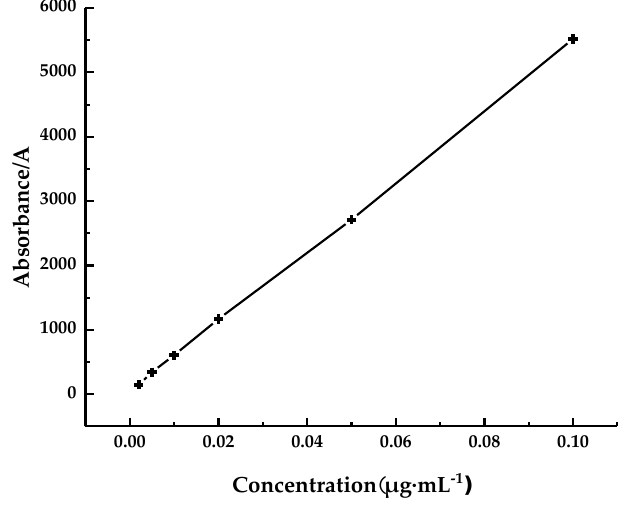
Figure 18. Rhodamine B solution standard concentration absorbance curve.